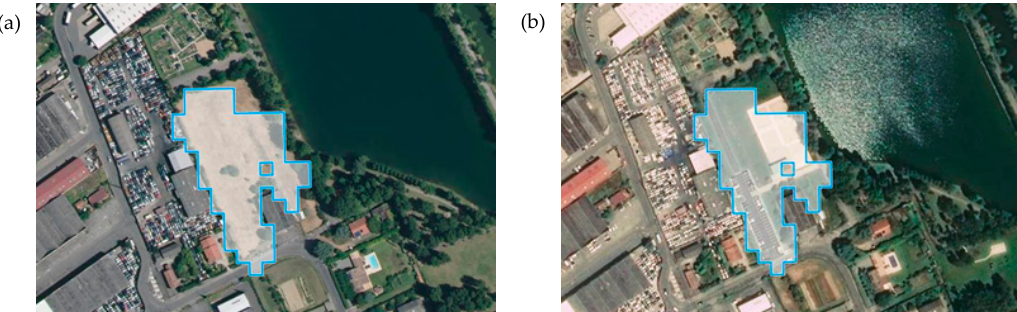
Figure 12. Example showing a change detected by the CDS as Industrial and considered as Industrial by the reference overlaid on an orthophoto for ( a ) 2016-Geoportal©IGN and ( b ) 2019-Geoportal©IGN.